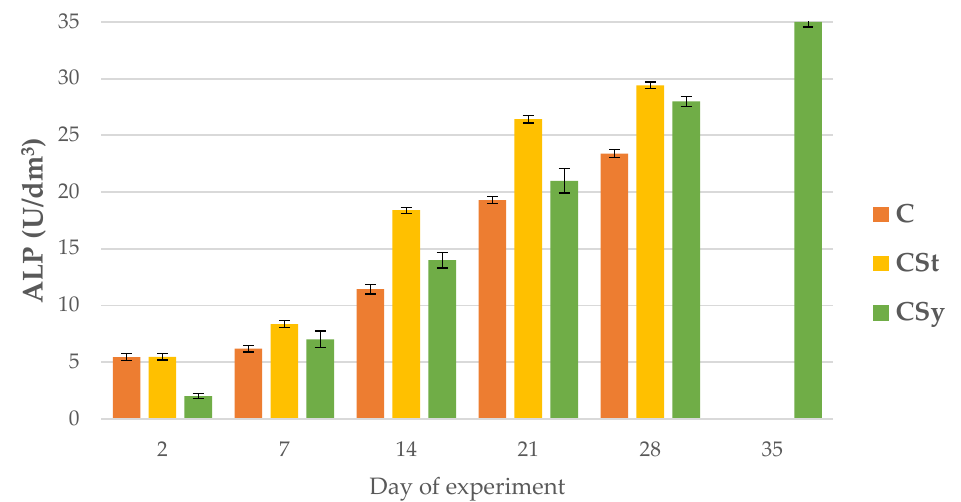
Figure 8. ALP activities in the 2, 7, 14, 21, 28, 35-day-old honey bees’ hemolymph after two methods of supplementation with hemp extract: C-control (pure sugar syrup), CSy-hemp extract in syrup, CSt-hemp extract on strips. (Two-Way ANOVA: supplementation method: F (2, 156) = 18.598, p = 0.0000, se ± 1.275927 – 1.411898; days of supplementation: F (4, 143) = 13672, p = 0.0000, se ± 0.089307 – 0.151897; supplementation method × days of supplementation F (8, 143) = 300.67, p = 0.0000, se ± 0.0151897.